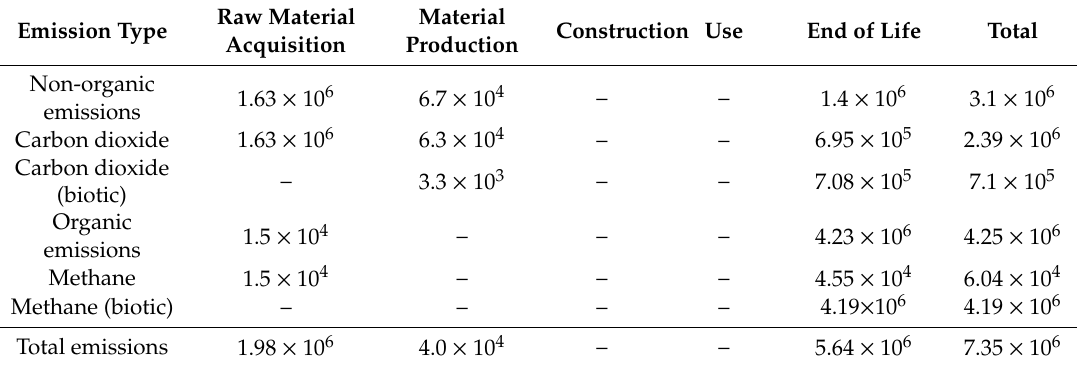
Table 9. Emissions to air by the steel building (kg CO 2